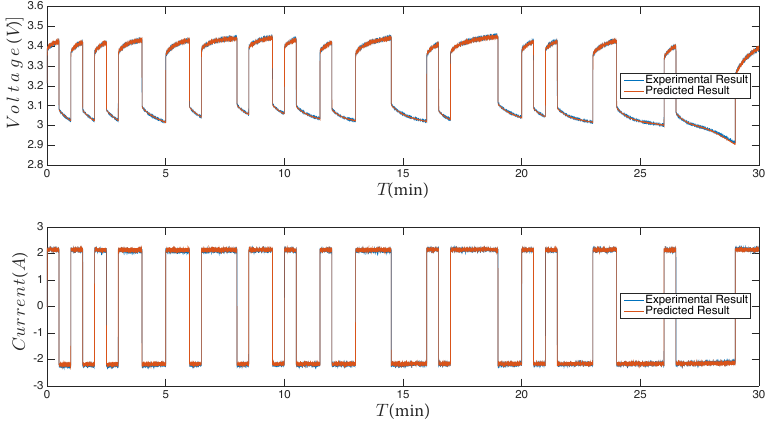
Figure 8. Validation results of the dynamic voltage and current models with one-step-ahead voltage and current predictors ˆ v ( t | t − 1 ) and ˆ i ( t | t − 1 ) in the first 30 min.